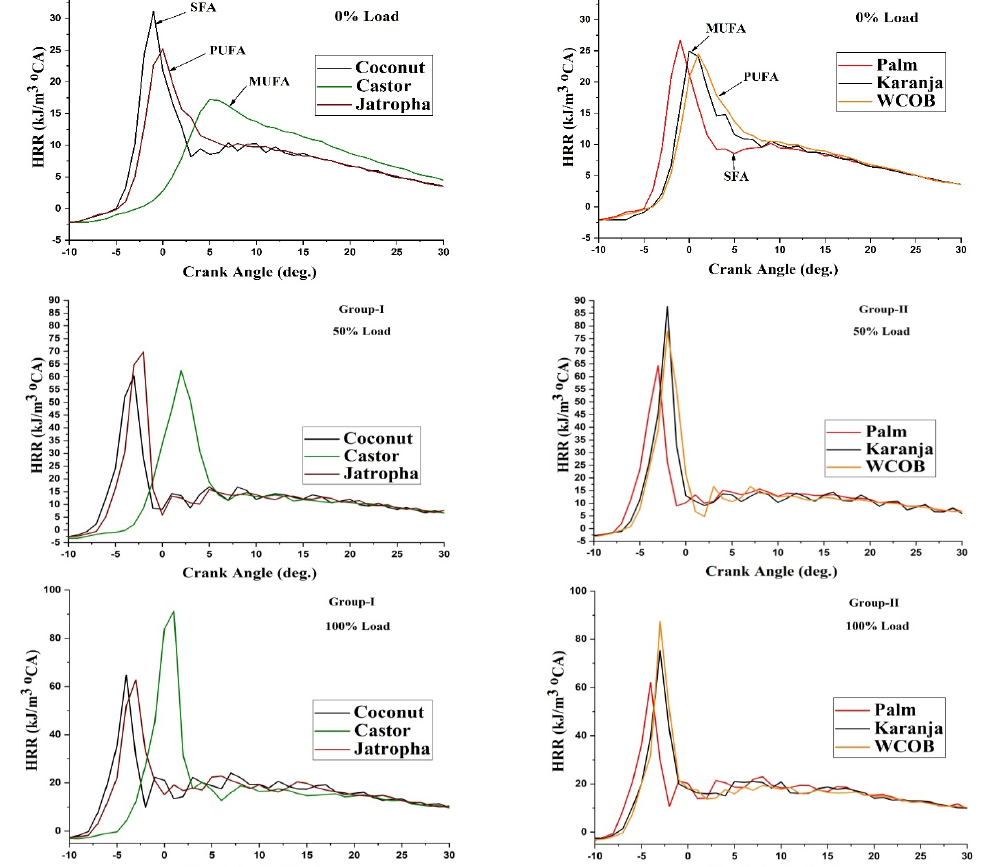
Figure 8. Heat release rate at 0%, 50%, and 100% load.